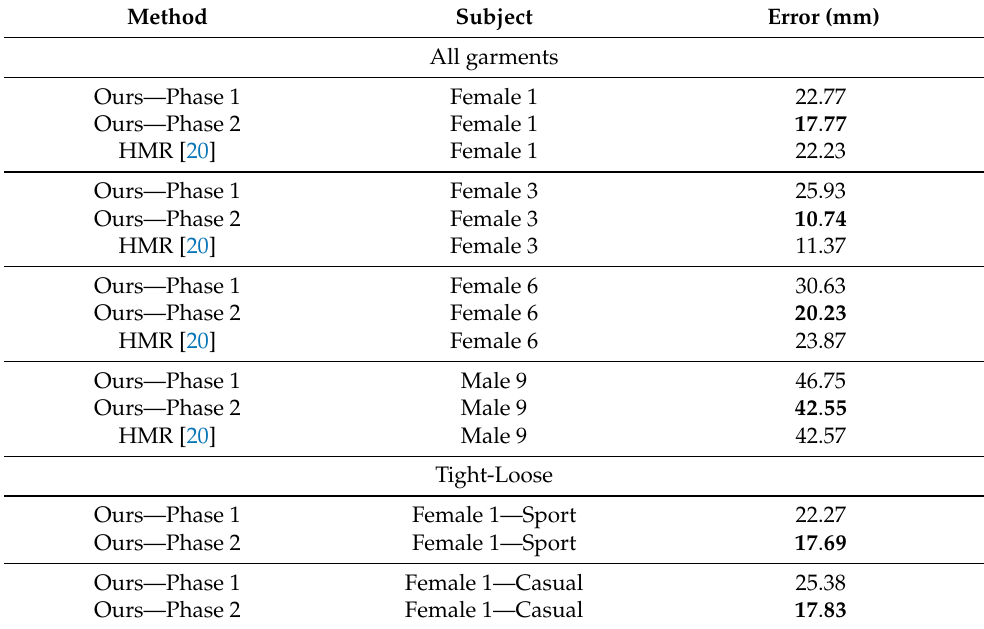
Table 2. Quantitative results on some test samples of the People Snapshot dataset in terms of MPVE (mm). Table in the “All garments” side reports average reconstruction errors compared to HMR (averaged over all garments). Our method after fine-tuning obtains accurate reconstructions. Table in the “Tight-Loose” side highlights the improvement obtained on loose clothes (casual) after fine-tuning the model with parameters associated with the minimally clothed version